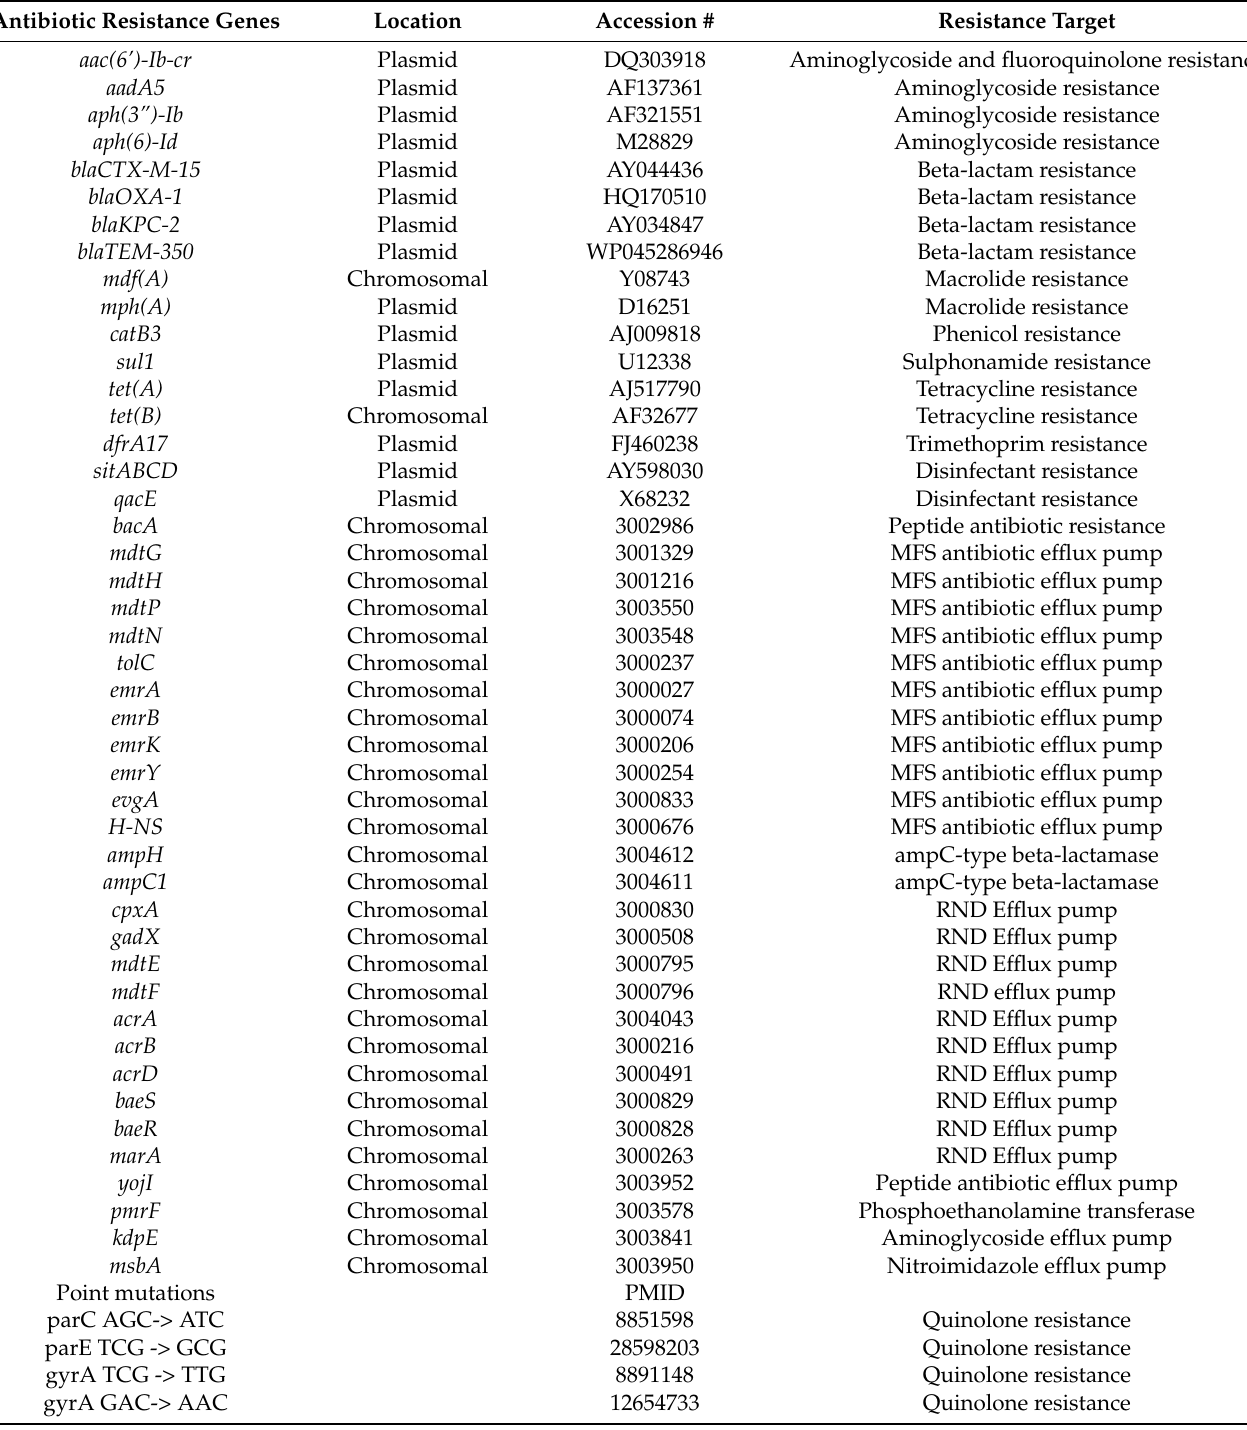
Table 3. Resistome of MDR hospital wastewater E. Coli 1000C-3